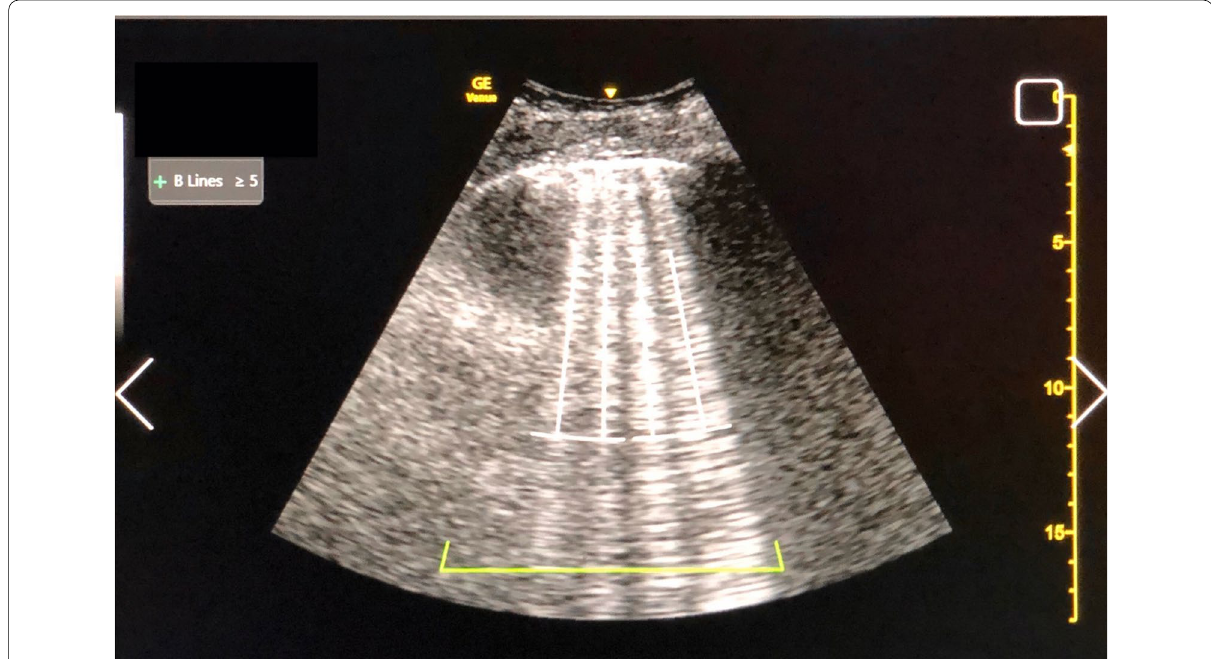
Fig. 1 Lung ultrasound image of B-lines using machine AI for quantification. This image shows the zone analyzed (green line at bottom) and demonstrates 5 ≥